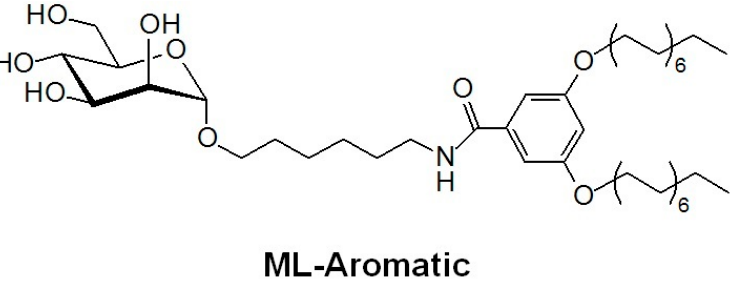
Figure 2. Structure of ML-Aromatic.